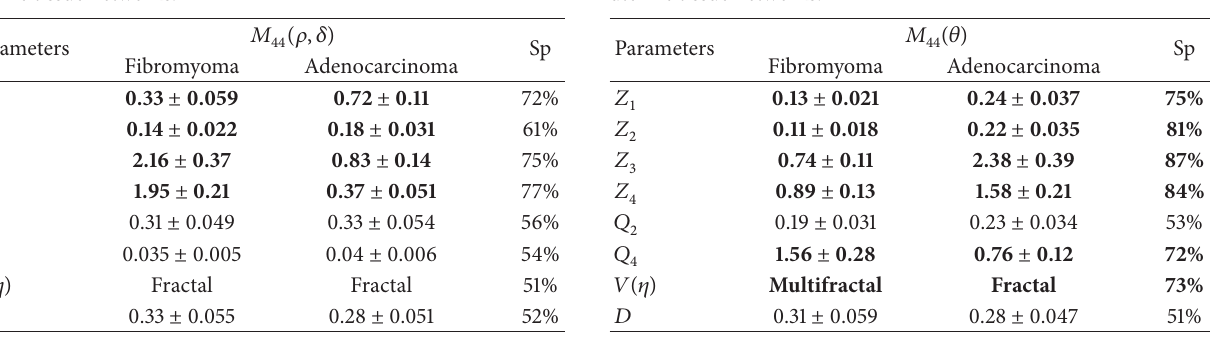
Table 1: Parameters of the statistic, correlation, and self-similar structure of 𝑀 44 (𝜌,𝛿) of linear birefringence of polycrystalline uterine tissue networks.